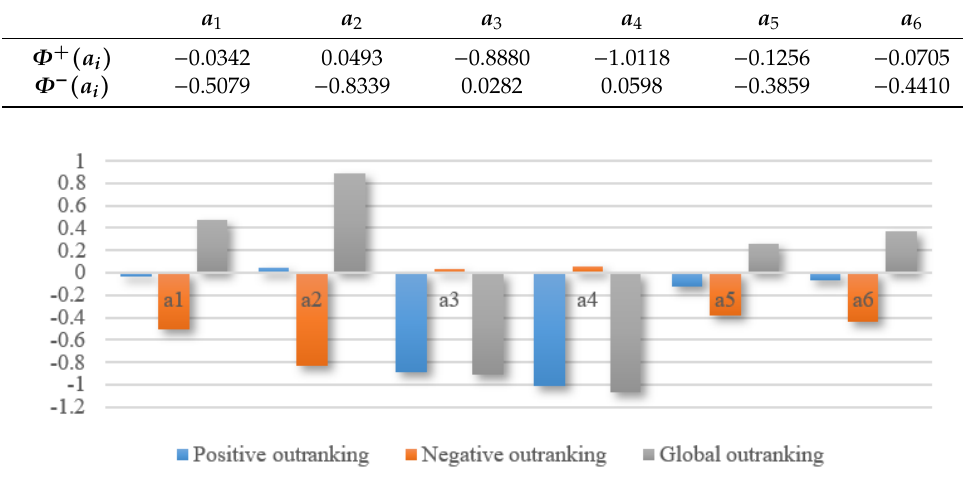
Figure 4. The outcome of positive, negative and global outranking.